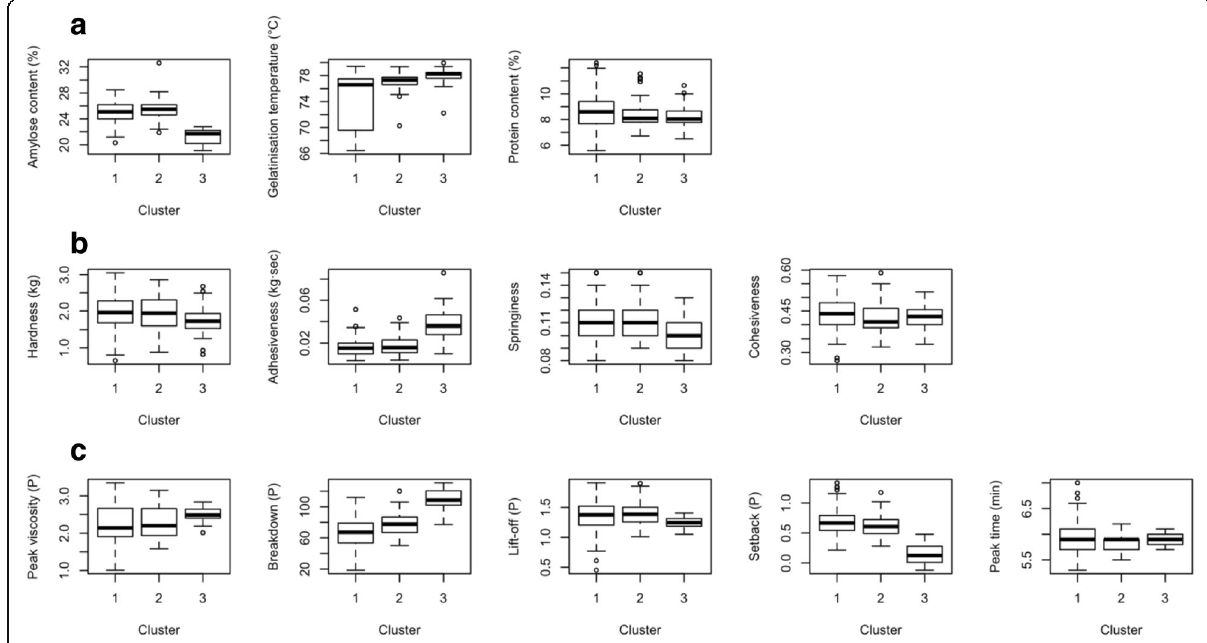
Fig. 2 Boxplots of the three clusters of rice samples for ( a ) GT, AC, and PC; ( b ) TPA parameters: HRD, ADH, COH, SPR; ( c ) RVA parameters PV, BD, LO, SB, and Peak time;